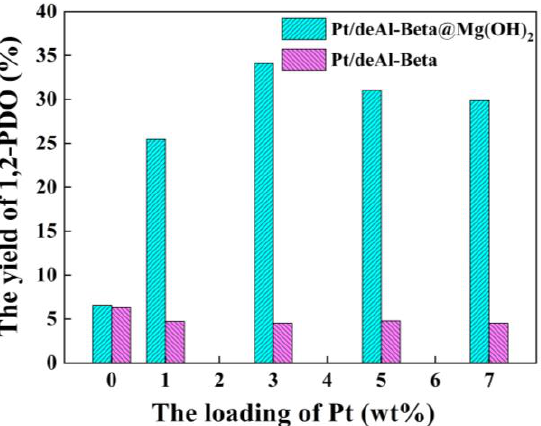
Figure 2. The effect of Mg(OH) 2 and Pt loading on glucose hydrogenolysis into 1,2-PDO. Reaction condition: catalyst (200 mg), glucose (11.25 mg/mL, 10 mL) and H 2 (initial 6 MPa) at 200 °C for 3 h.